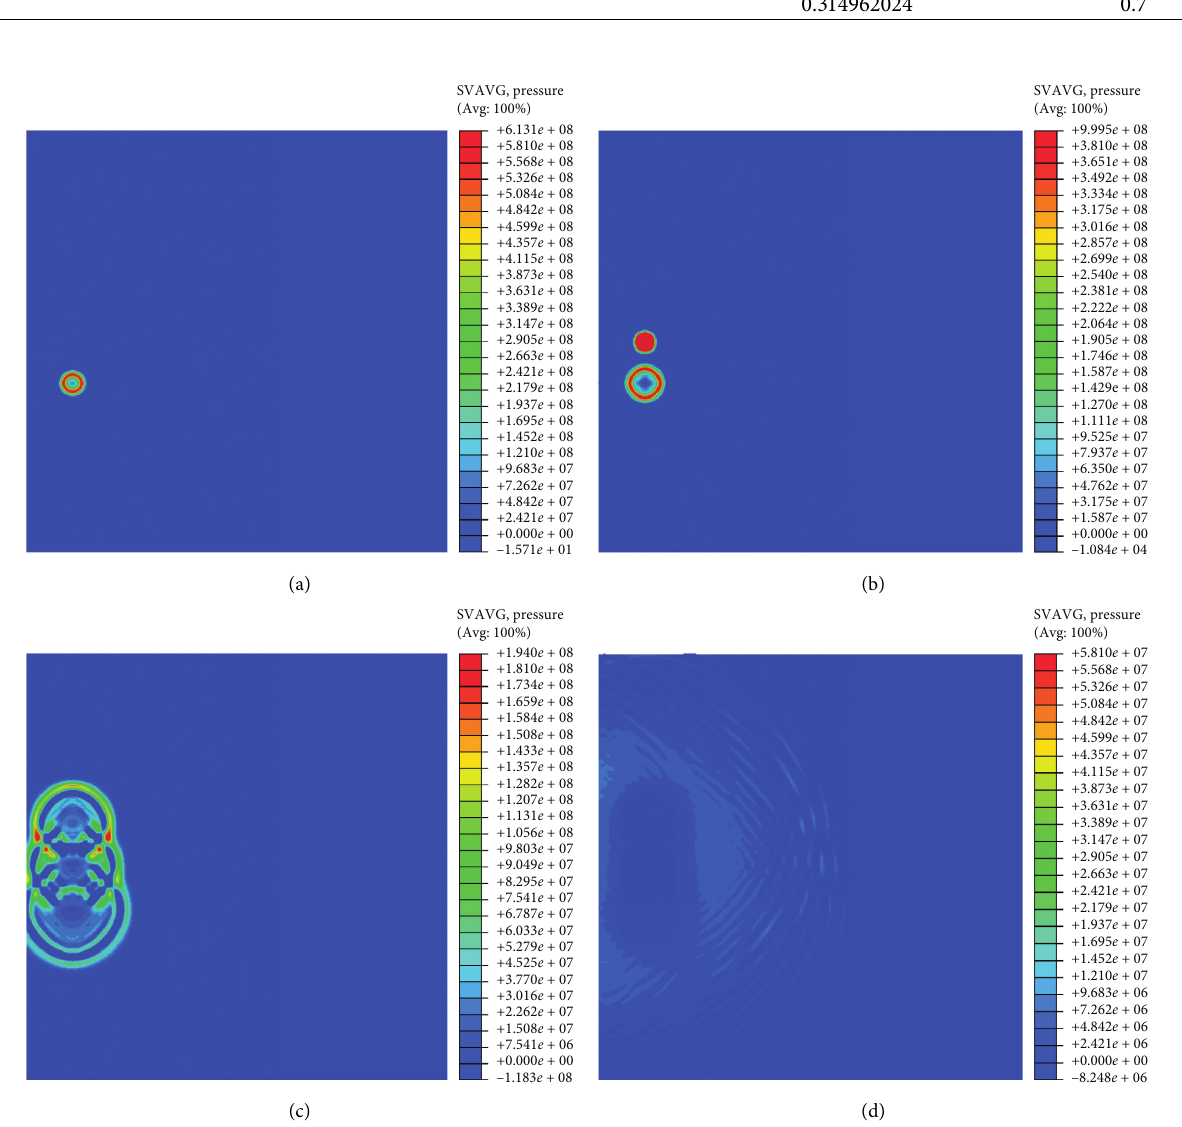
Figure 3: Stress nephogram of 10ms delayed SVAG pressure. (a) 8ms. (b) 12ms. (c) 22ms. (d) 25